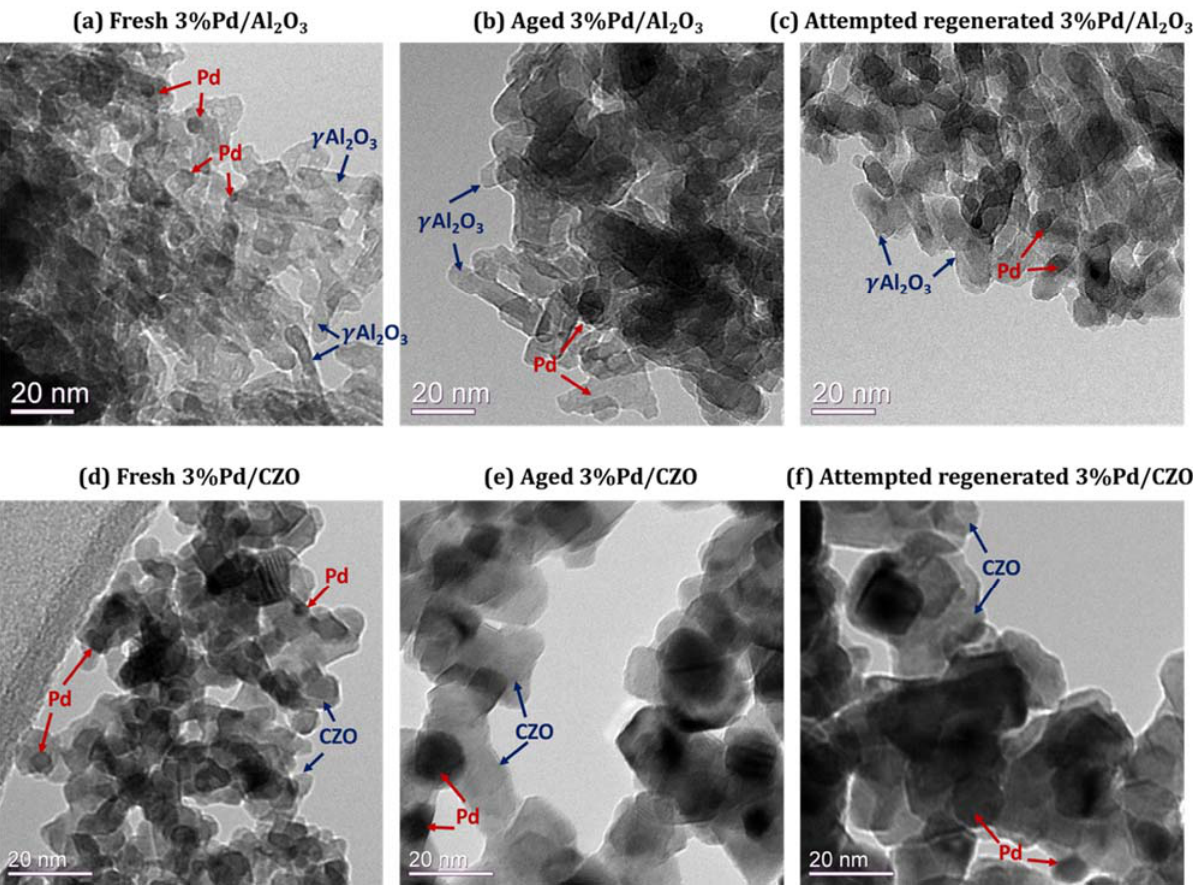
Figure 6. Representative TEM images of fresh, aged, and attempted regenerated 3% Pd/Al 2 O 3 ( a – c ) and 3% Pd/CZO ( d – f ). Aged samples were achieved by aging the